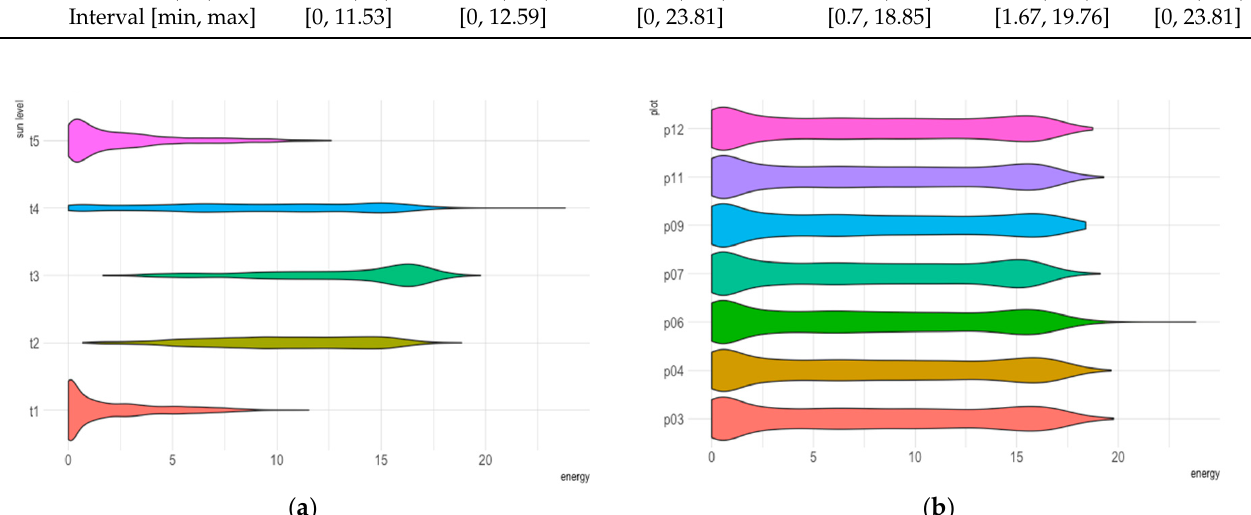
Figure A1. ( a ) Distribution of energy at different sun level. ( b ) Distribution of energy at different plots.